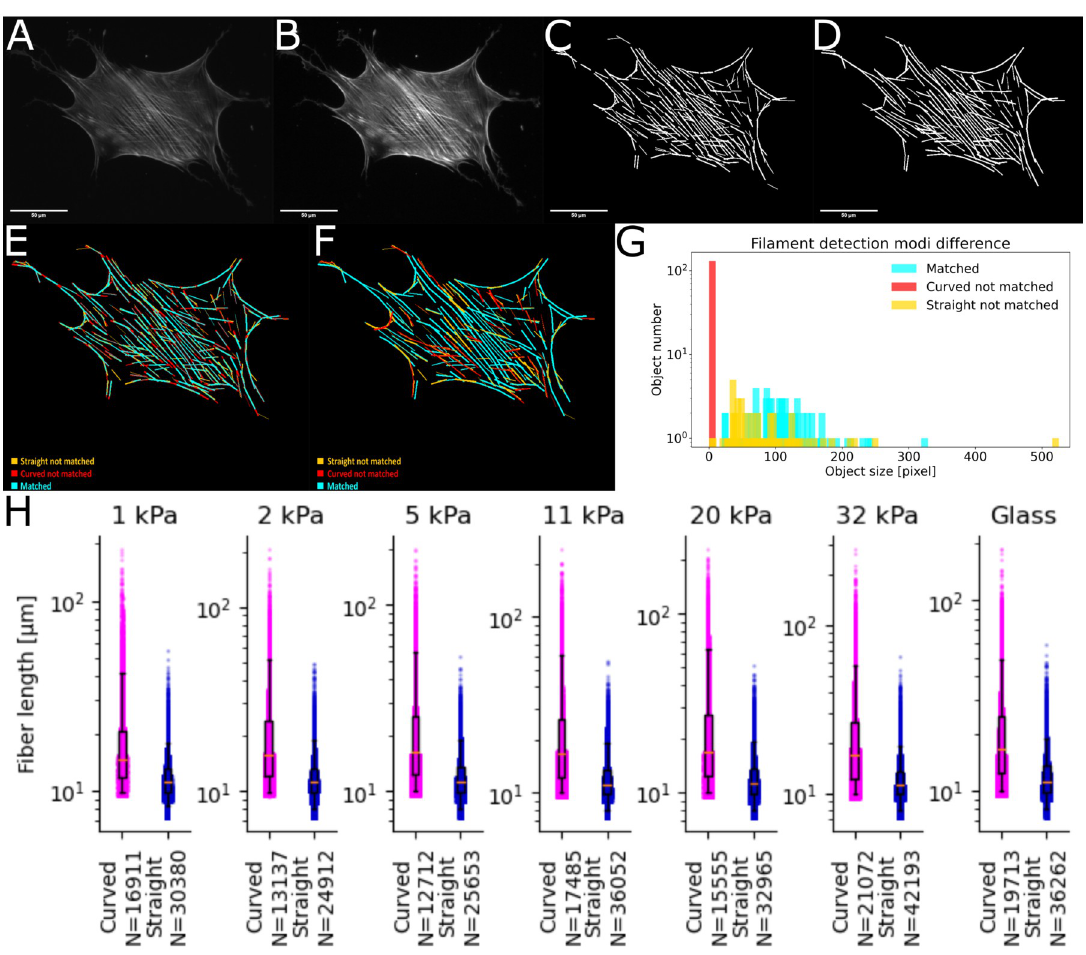
Fig 3. Example of straight versus curved filament tracing. A : Raw image of hMSC on collagen-I coated glass. B : Result of FS2.0 filtering during pre-processing. C : Filaments found using straight filament detection. D : Filaments found using curved filament detection. E : Pixel-wise comparison of filaments found with straight and curved settings. Straight settings used as ground truth. Orange: Pixel only in straight detection. Red: Pixel only in curved detection. Blue: Pixel present in both settings. F : Object-wise comparison of filaments found with straight and curved settings. Straight settings used as ground truth. Orange: Object only in straight detection. Red: Object only in curved detection. Blue: Object present in both settings. Comparison was done with setting so that 75% of the object needs to be matched to count as same object. G : Histogram of object size for all three filament categories, colors matched to pictures. H : Comparison of all filaments in the ground truth data set for straight and curved settings. We performed a Kolmogorov–Smirnov test between each pair of conditions. All p-values are <